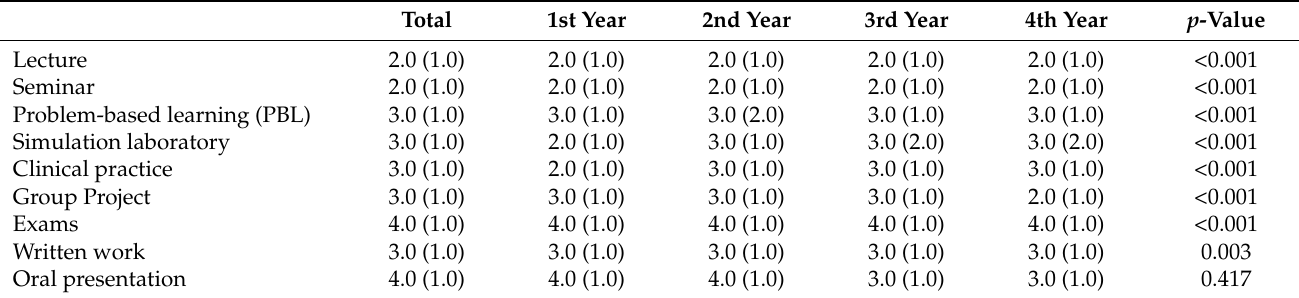
Table 3. Stress levels by different learning methodologies per academic year.